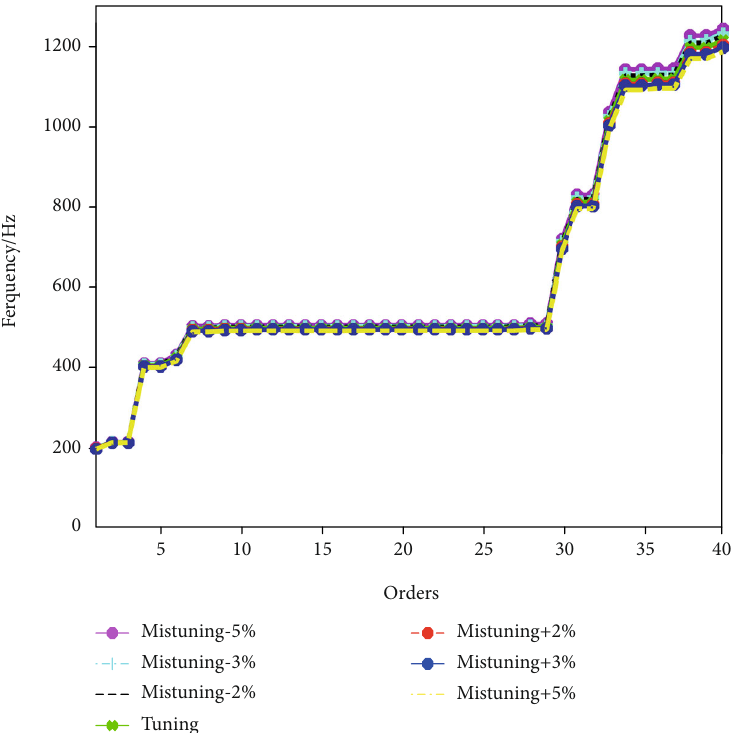
Figure 7: Natural frequencies of mistuned blisk with density